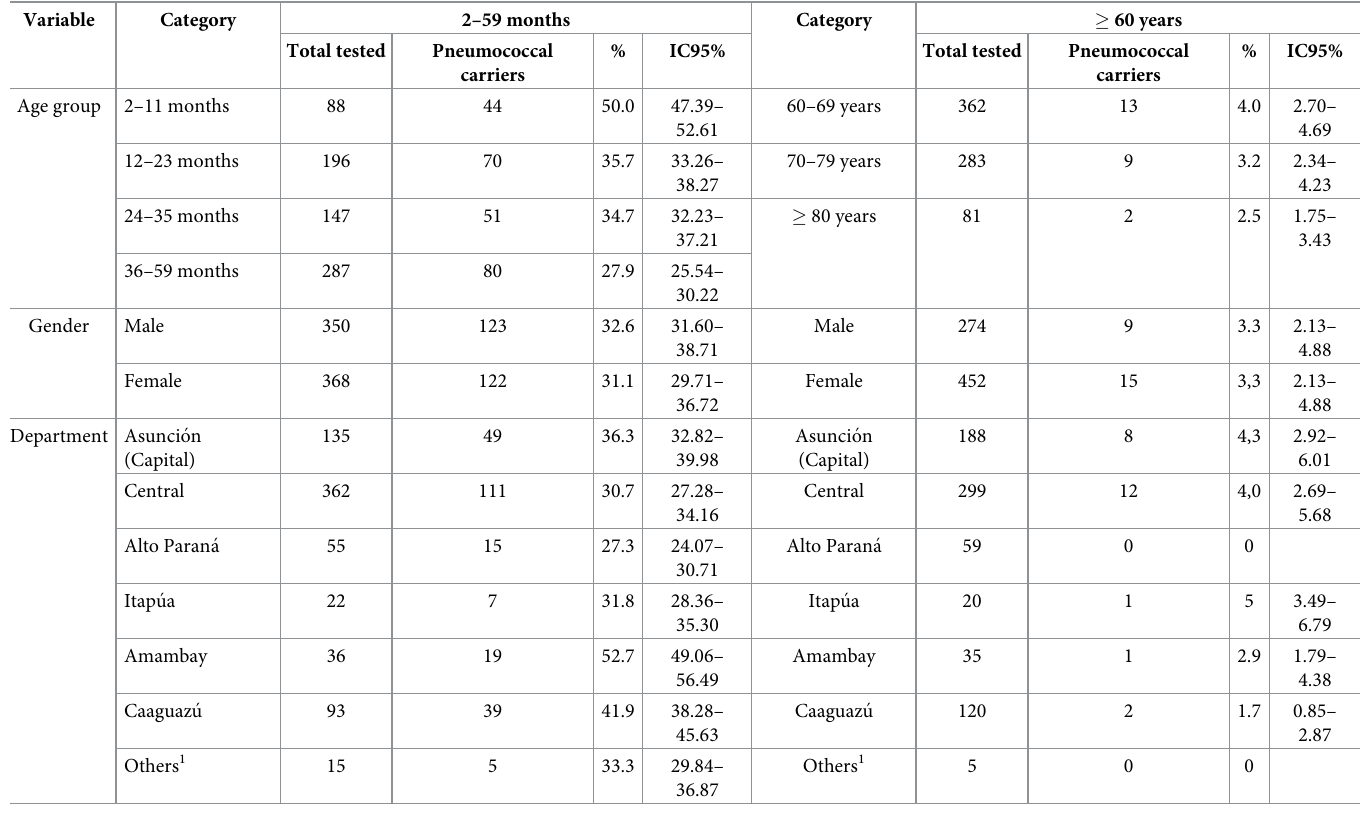
Table 1. Prevalence of pneumococcal colonization of the study population by age group (n = 1444). Variable Category